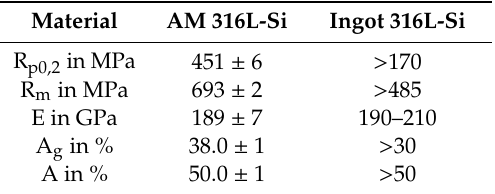
Table9. Averagematerialpropertiesoftheheattreated316L-Sispecimensandthematerialspecifications according to [30].